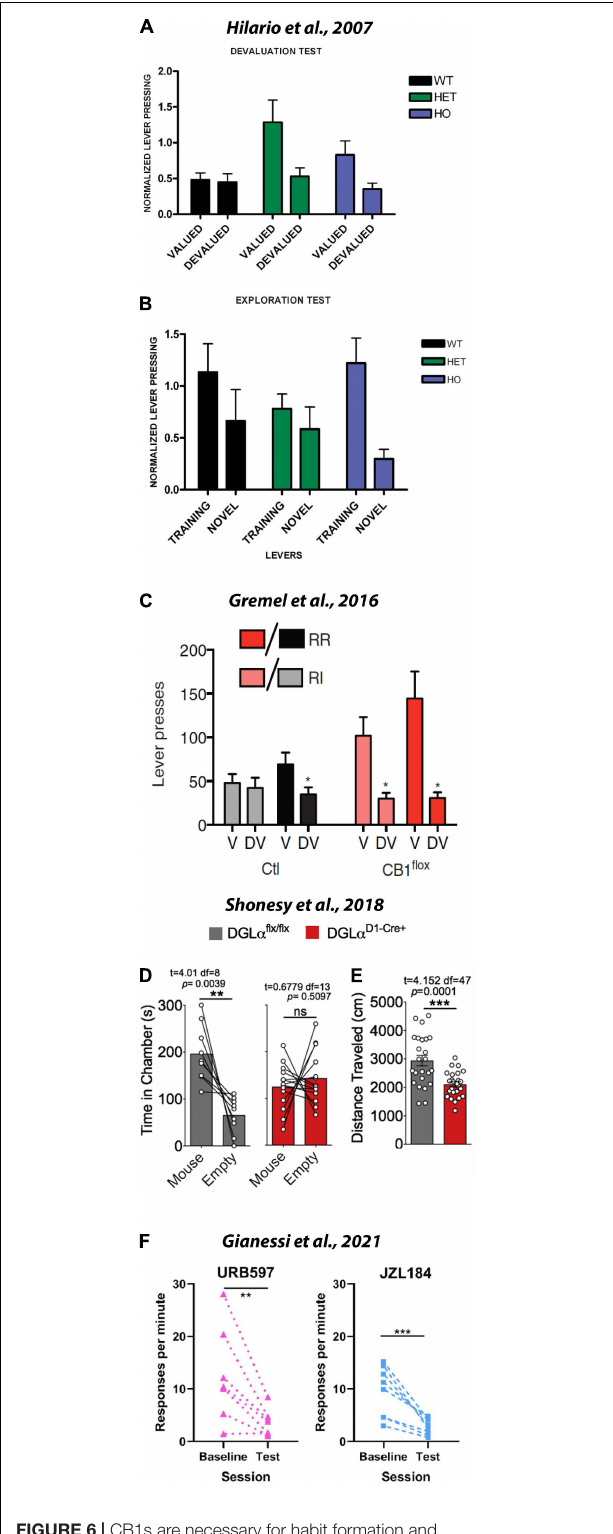
FIGURE 6 | CB1s are necessary for habit formation and adjunctive/exploratory behavior. To investigate the role of eCBs in habit formation and adjunctive behavior WT, CB1 + / − , and CB1 − / − were trained